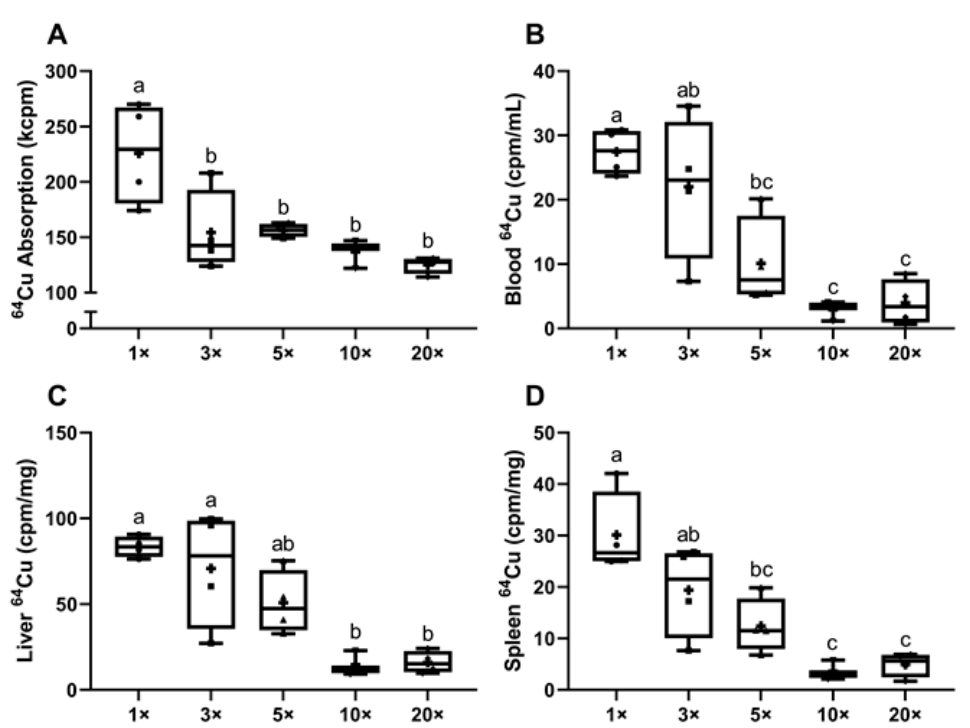
Figure 5. 64 Cu absorption and accumulation in blood, liver, and spleen were lower in iron-supplemented dams. Shown are intestinal copper ( 64 Cu) absorption ( A ) and 64 Cu activity in blood ( B ), liver ( C ), and spleen ( D ) of dams fed diets varying in iron concentration for ~3.5 weeks. One-way ANOVA analysis results are as follows: 64 Cu absorption ( A ), p = 0.0019; 64 Cu in blood ( B ) and liver 64 Cu ( C ), p = 0.0004; and spleen 64 Cu ( D ), p = 0.0002. When statistically significant differences were noted by one-way ANOVA, Tukey’s post hoc test was utilized to make comparisons between individual groups. Values without common superscript letters are statistically different from one another ( p < 0.05 ) ( A–D ). All data points are shown, and the mean values are indicated by “+” signs.